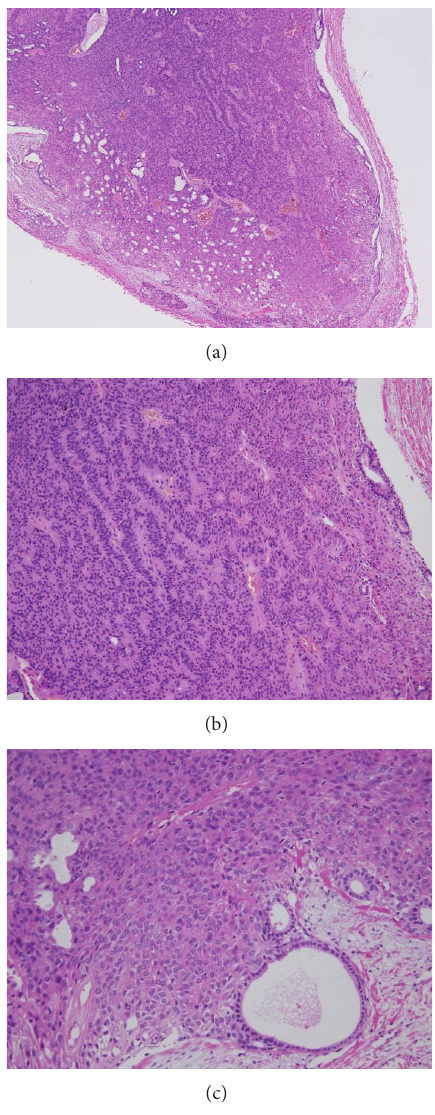
Figure 3: Histopathology of the surgical specimen using hematoxylin-eosin (H-E) staining. (a) The tumor was surrounded by a thin capsule and did not involve any normal salivary gland tissue (H-E × 40). (b) Proliferation of monomorphic epithelial cells with a trabecular pattern and variably sized nests of cuboidal cells (H-E × 100). (c) Proliferation of monomorphic epithelial cells of a tubular type (H-E ×